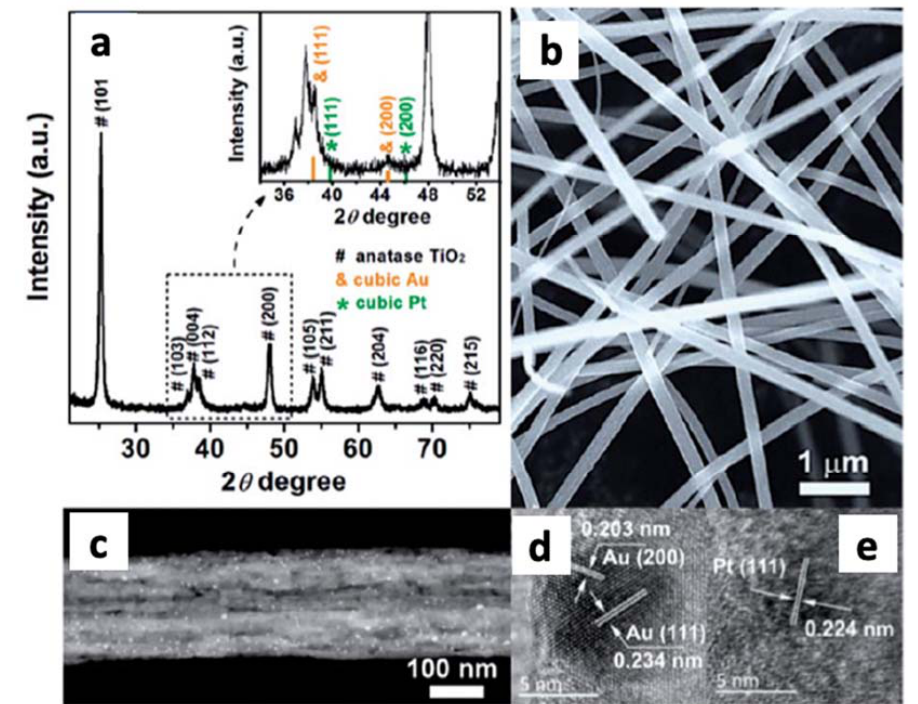
Figure 28. ( a ) XRD pattern, ( b ) SEM image, and ( c ) dark-field STEM image of the Au 0.75 /Pt 0.25 /TiO 2 nanofibers; HRTEM imafes of ( d ) Au NPs. Reproduced with permission from reference [146].